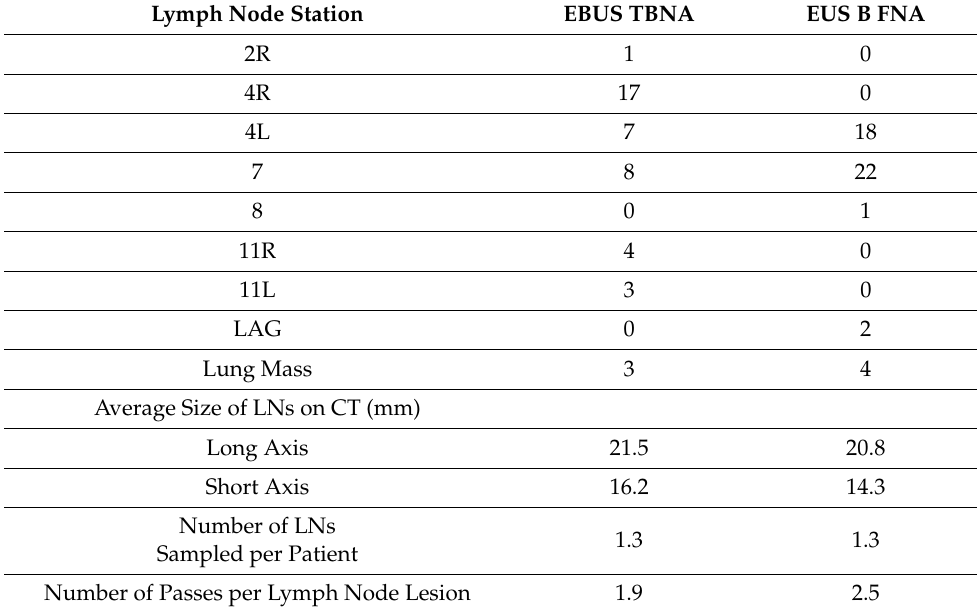
Table 3. Number of lymph nodes or lesions sampled according to stations by EBUS TBNA and EUS B FNA. Lymph Node Station EBUS TBNA EUS B FNA